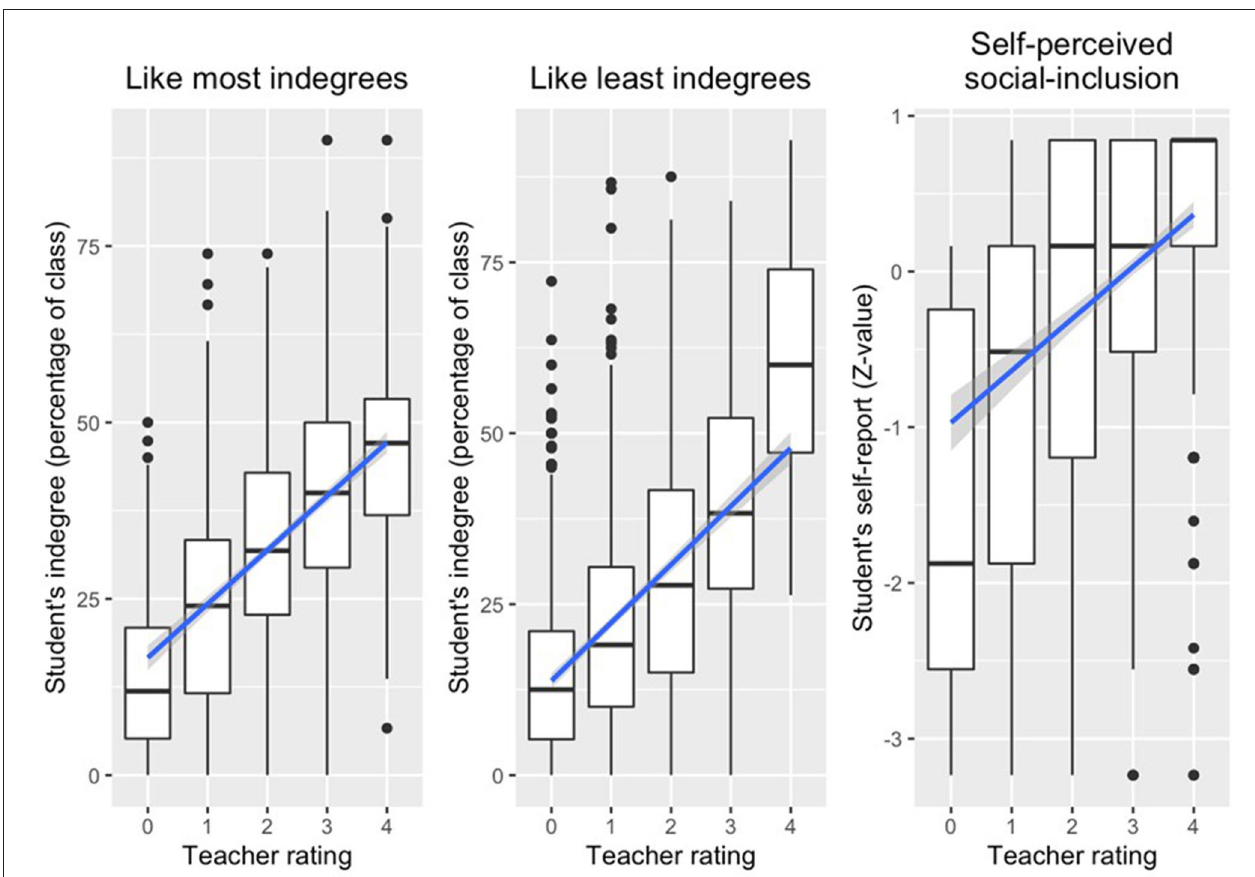
FIGURE 1 | (A–C) Concordance between teachers’ ratings (from 0 to 4) and students’ attributes (in percentage of indegrees received from participating class peers for the sociometric measures and Z -values for the self-perceived social-inclusion). The horizontal lines within the boxplots indicate the median, the lower and upper hinges correspond to the first and third quantiles, the whiskers extend to the largest and lowest values, but not further than 1.5 times the interquartile range (difference between third and first quantiles) from the respective hinge. All values outside the whiskers are depicted as dots and considered to be outliers. The diagonal lines depict regression lines with a gray area indicating the standard errors.